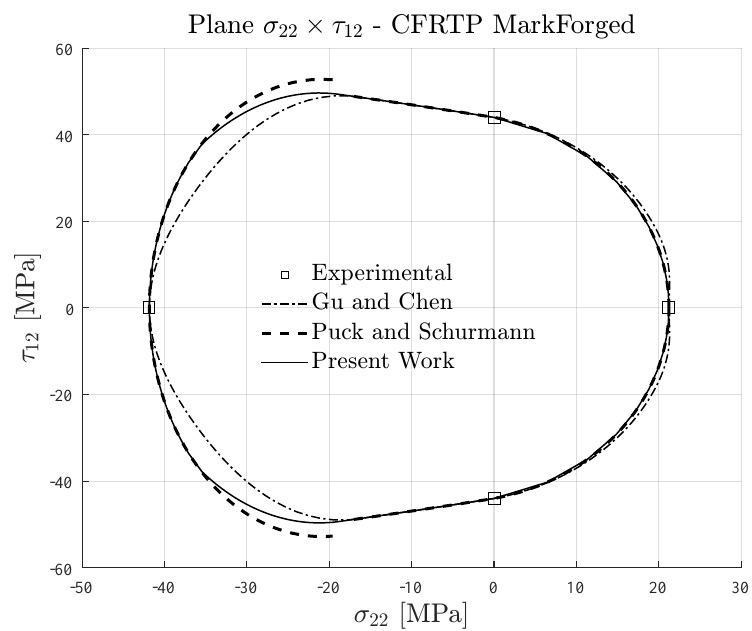
Figure 9. Failure envelopes on the stress space σ 22 × τ 12 for 3D-printed continuous carbon fiber reinforced thermoplastic lamina. Inclination parameter p c ⊥⊥ = 0.2 for Puck and Schürmann and Expanded Puck and Schürmann.